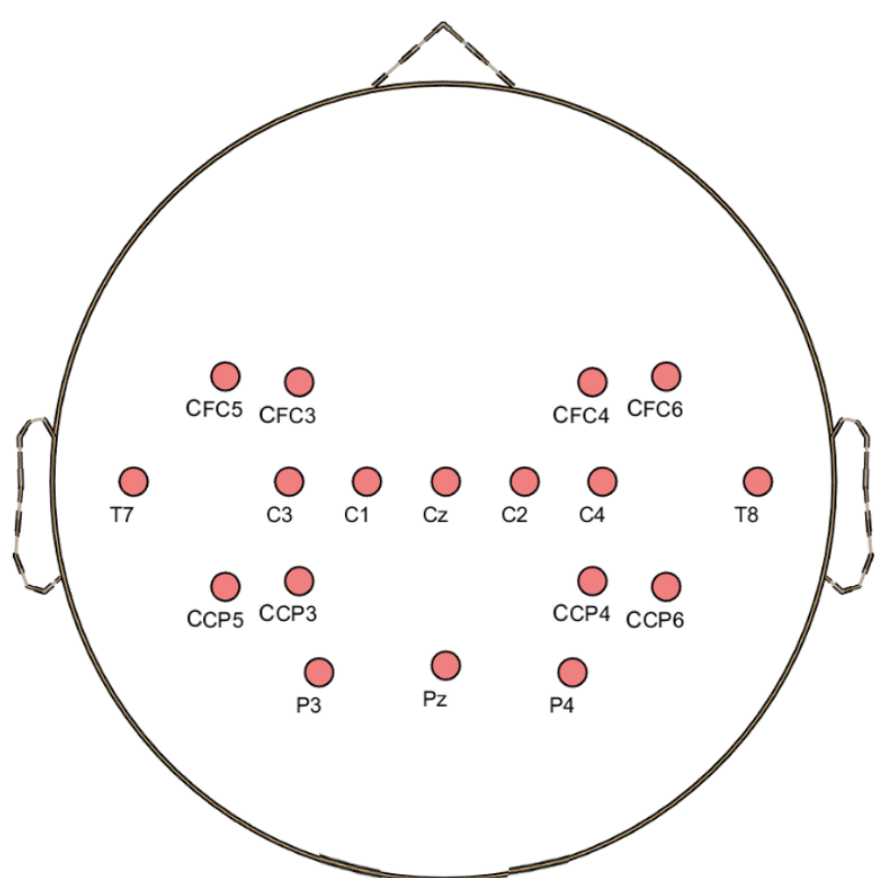
Figure 2. Locations of the 18 channels ( K = 18) in BCI Competition III Dataset